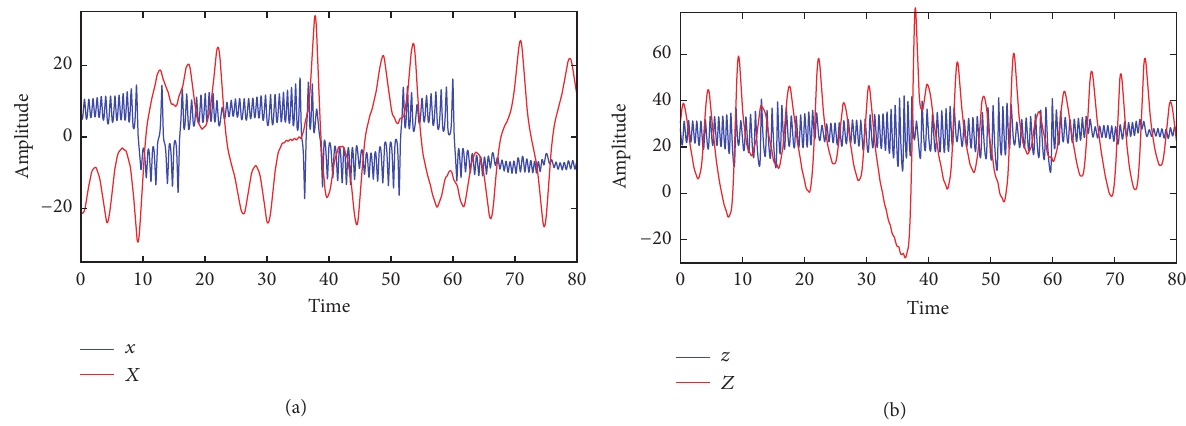
Figure 2: Fast ( 𝑥 and 𝑧 ) and slow ( 𝑋 and 𝑍 ) variables for the case of 𝑐 = 0.5